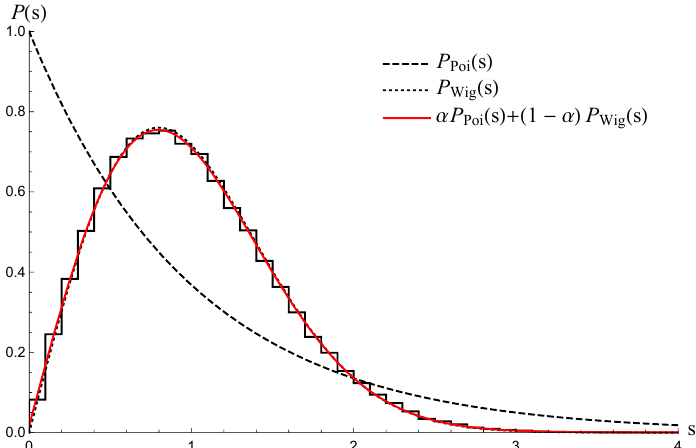
= 1 and k = 2 π/ 24 T